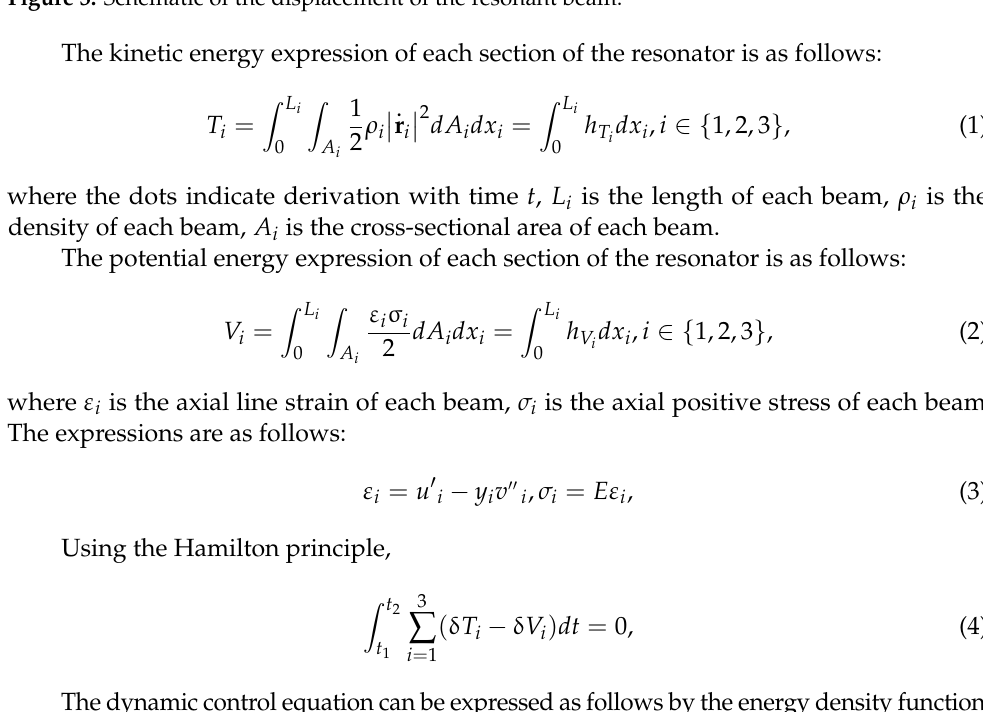
Figure 3. Schematic of the displacement of the resonant